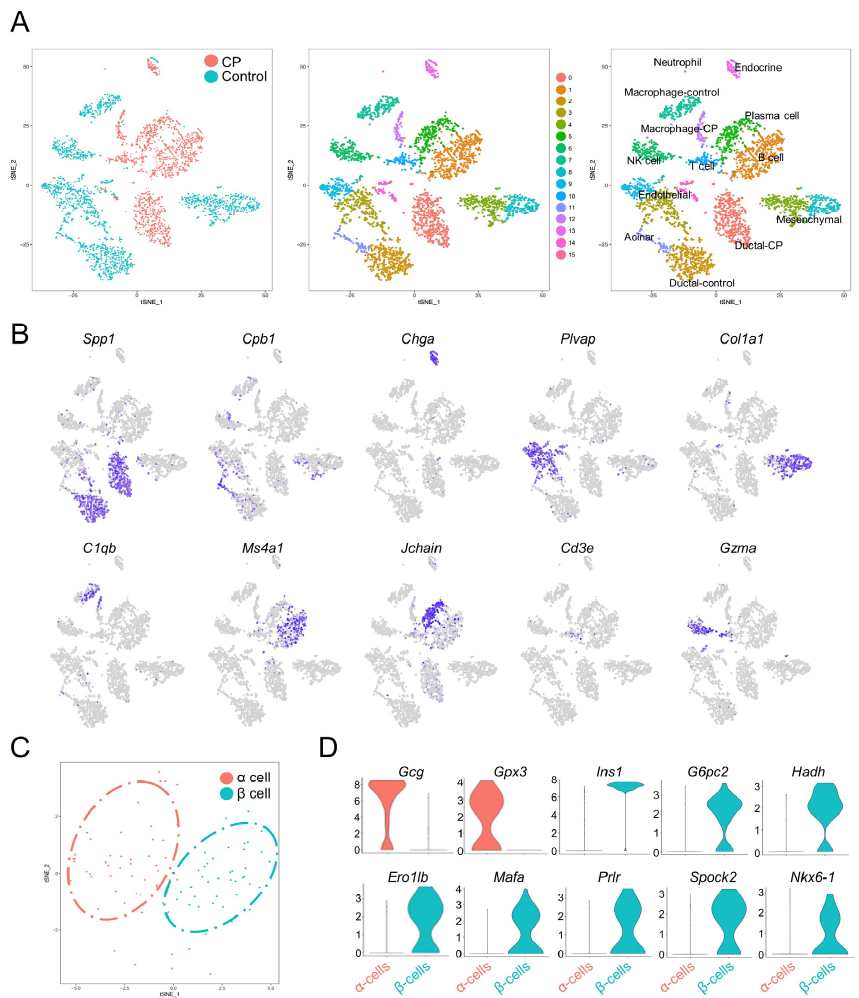
Figure 2. Single-cell transcriptomes recapitulate pancreatic cell types. ( A ) t-SNE plots of 3825 cells from mouse pancreata annotated by distinct tissue samples (left panel), and specific cell types distinguished by gene expression (right panel). ( B ) Heatmap illustrating specific markers in different pancreatic cell types. ( C ) t-SNE representation of α cells and β cells generated from sub-clustering the endocrine cell population, colored according to cluster assignments. ( D ) Violin plots illustrating the mRNA levels of representative marker genes in α and β cells. The y-axis displays the normalized read count.